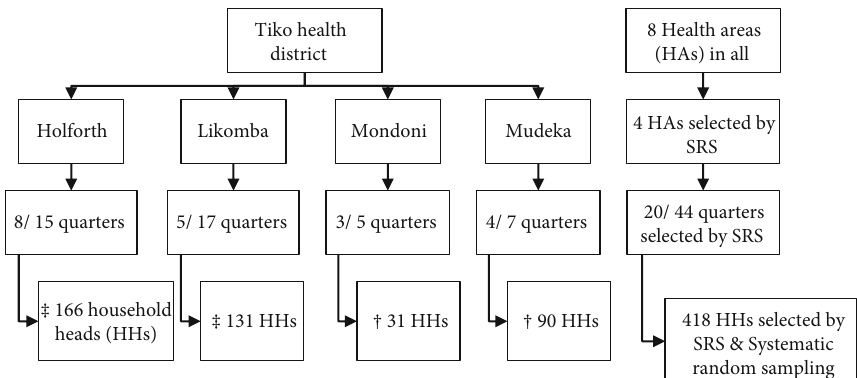
Figure 1: Multistage sampling. SRS: simple random sampling; HHs: household heads. ‡ HHs sampled by systematic random sampling, † HHs sampled by